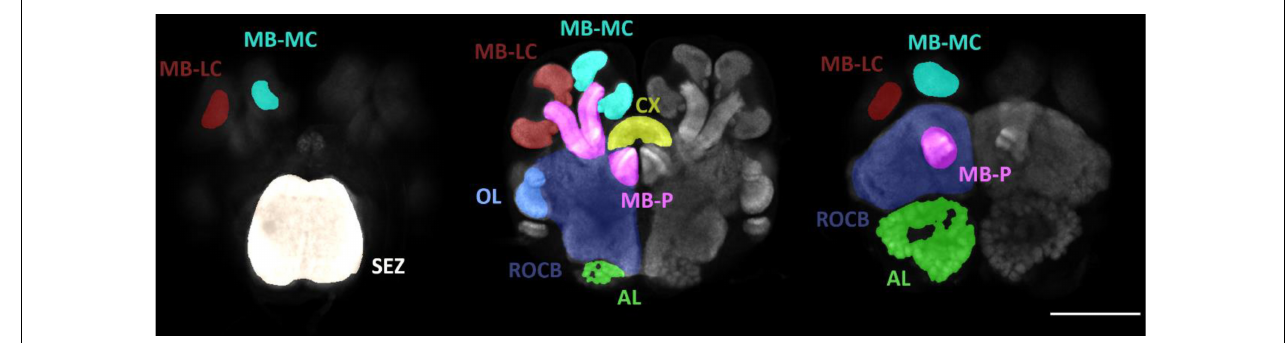
FIGURE 1 | Anatomy of a P. spadonia minor brain. MB-LC (mushroom body lateral calyx), MB-MC (mushroom body medial calyx), SEZ (subesophageal zone), OL (optic lobes), AL (antennal lobes), MB-P (mushroom body peduncle), CX (central complex), and ROCB (rest of the central brain). Scale bar = 100 um. Three brain slices have been selected to show all the subregions